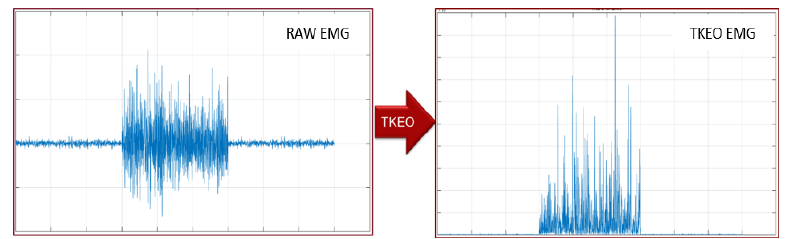
Figure 4. Raw and Teager-Kaiser Energy Operator (TKEO) EMG signal, on the same time and amplitude scale.